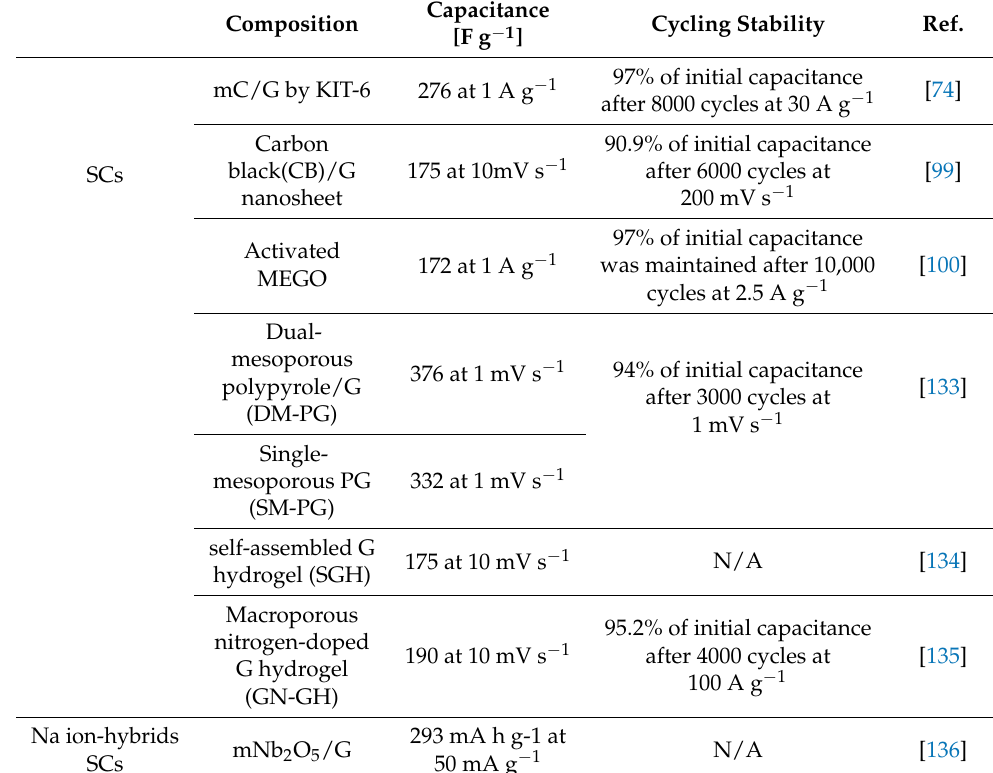
Table 2. The G-based 2D mesoporous materials for supercapacitor (SC)